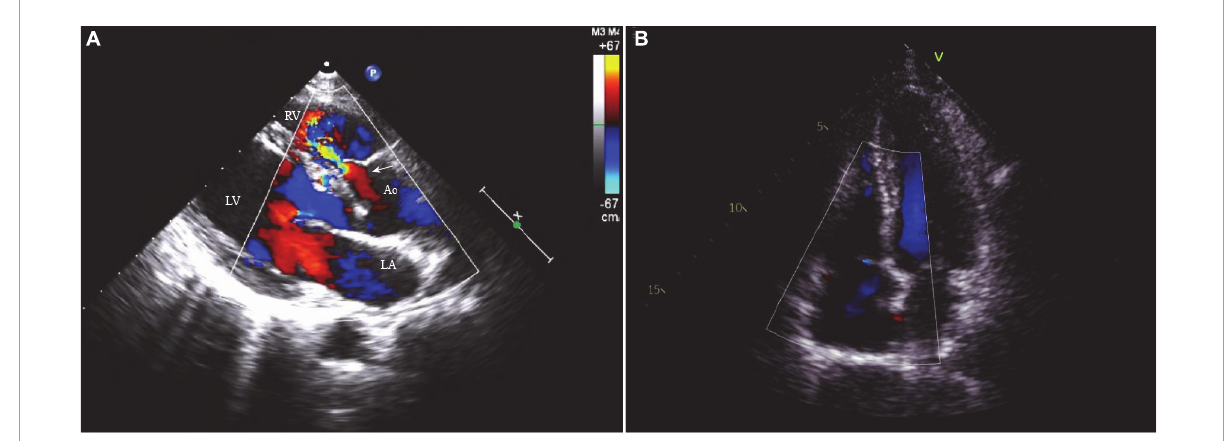
FIGURE1 (A) The two-dimensional echocardiogram showed a 10.6 mm × 9.6 mm ruptured sinus of Valsalva aneurysm (right coronary sinus) and a 5.0 mm aortocardiac shunt ( white arrow ). (B) No residual shunt or valve regurgitation noted on the postoperative echocardiogram. LA, left atrium; LV, left ventricle; RV, right ventricle; Ao, aorta.